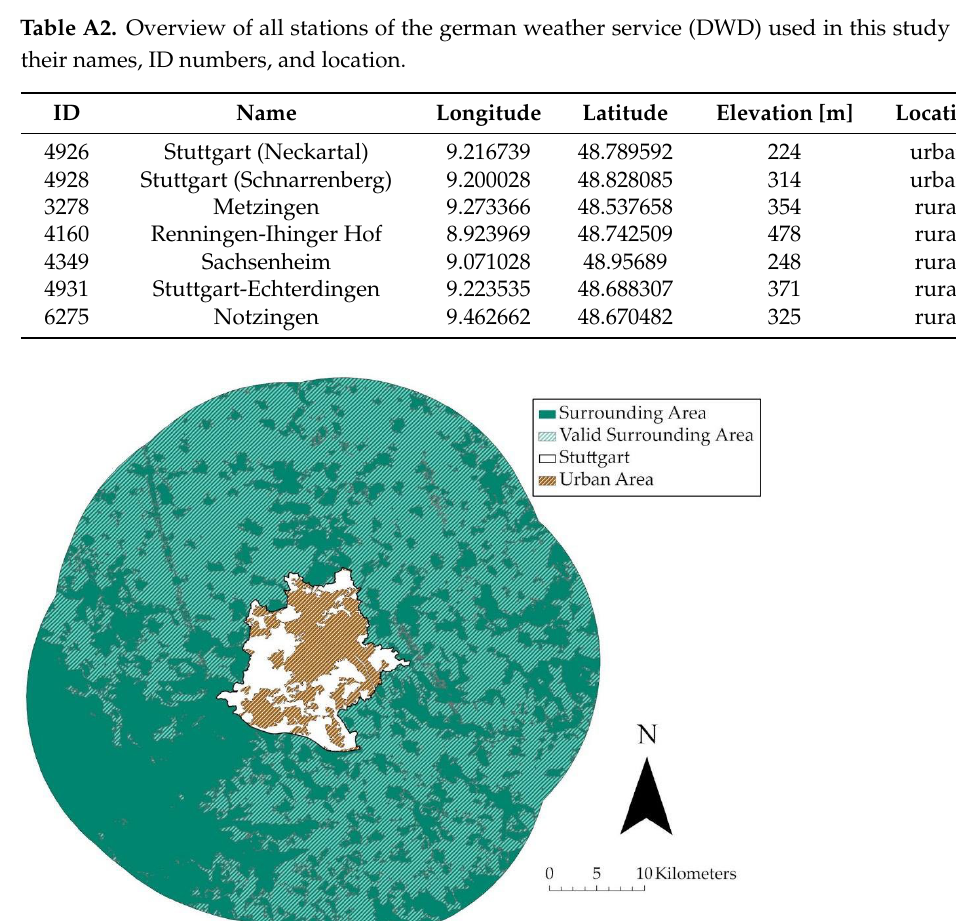
Figure A2. Correlation between the 2 metre air temperature (T Air ) from stations of the German weather service (DWD) in the administrative boundaries of Stuttgart [46] and land surface temper- ature (LST) from L5 and L8 averaged within a 60 m radius around each station. The dots show the LST data for every weather station in every Landsat tile used in this study and the corresponding 2 metre air temperature recorded the same day at 9 a.m. from the weather stations.